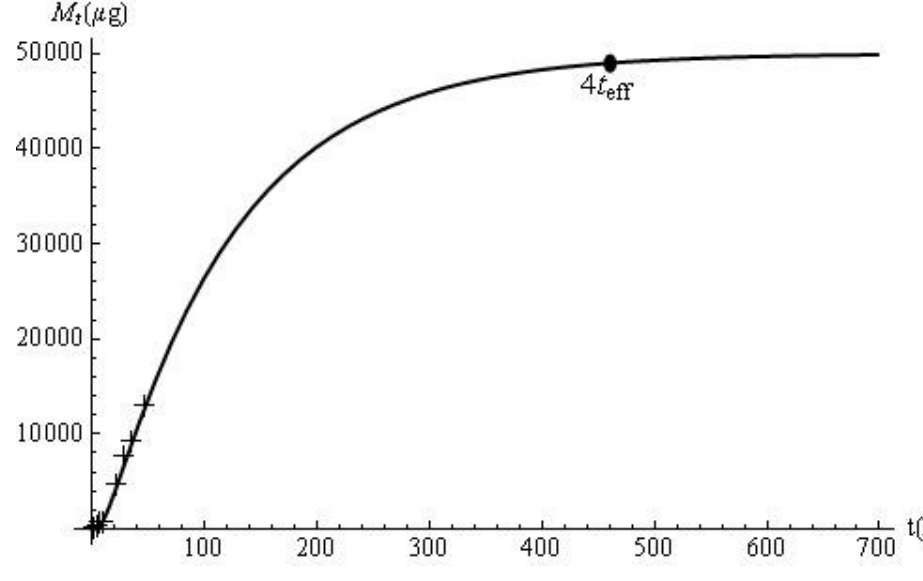
Figure 3. Cumulative amount of ATA released (experimental: +; predicted: –) and the response